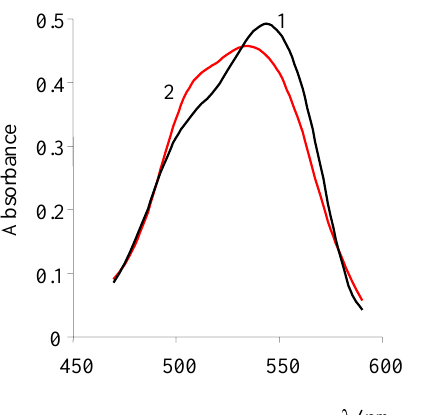
Figure 7 . Absorption spectra of DODR species in aqueous solutions of calix[4]arene (2.5 × 10 –3 M): ± , pH = 6 (2). HR + , pH = 1.2 (1) and R